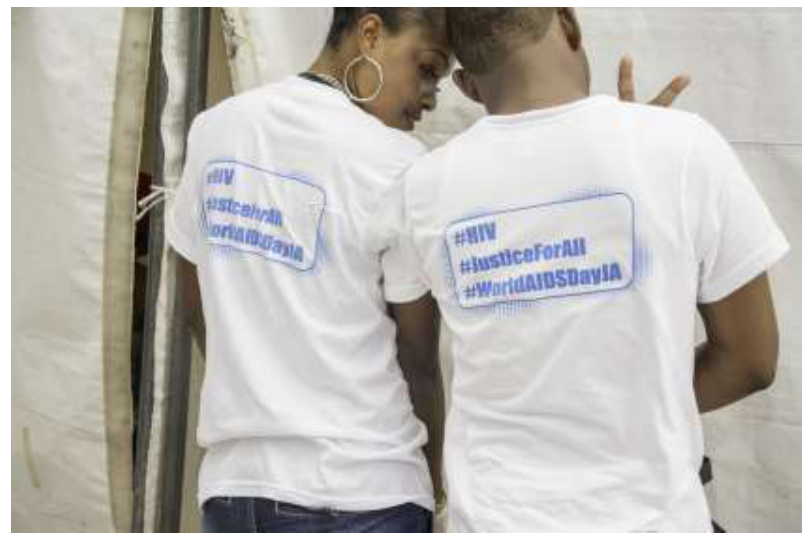
Figure 10. Volunteers from World AIDS Day 2013 volunteers wearing T-shirts displaying key words for social media